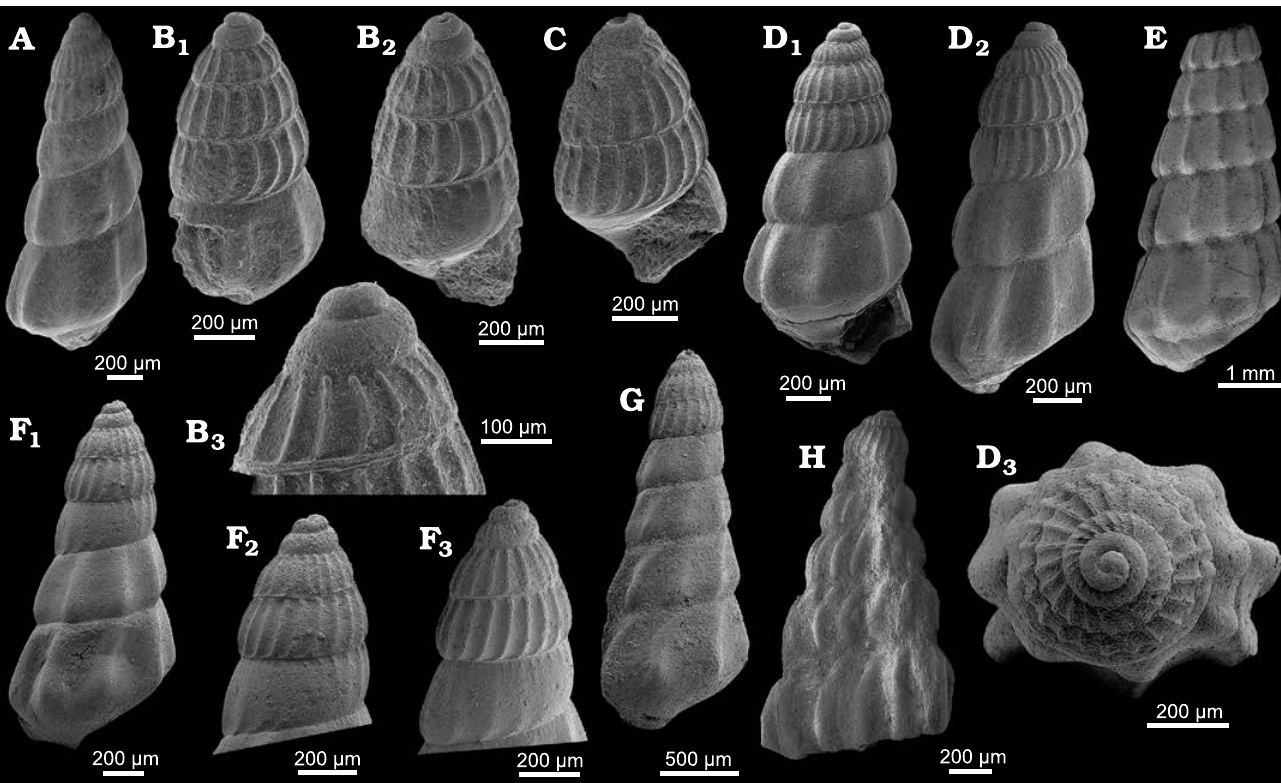
Fig. 17. Zygopleurid gastropods from Lago Antorno (A–C) and Misurina Landslide (D–H), northern Italy, Cassian Formation, Carnian, Upper Triassic. A . Ampezzopleura hybridopsis Nützel, 1998, PZO 12831, axially ribbed larval shell and 3 teleoconch whorls, in lateral view. B . Ampezzo pleura hybridopsis Nützel, 1998, PZO 12832, axially ribbed larval shell and 1 teleoconch whorl, in lateral view (B 1 ), B 2 , last whorl axial ribs reduced to subsutural nodes, in lateral view; B 3 , earliest whorls smooth, then strong axial ribs, in lateral view. C . Ampezzopleura hybridopsis Nützel, 1998, PZO 12833, axially ribbed larval shell. D . Ampezzo pleura hybridopsis Nützel, 1998, PZO 12705, axially ribbed larval shell and 2 teleoconch whorls, in apertural (D 1 ), lateral (D 2 ), and apical (D 3 ) views. E . Ampezzo pleura hybridopsis Nützel, 1998, PZO 12706, teleoconch. F . Ampezzopleura hybridopsis Nützel, 1998, PZO 12707, axially ribbed larval shell and 3 teleoconch whorls, in lateral view (F 1 ), F 2 , protoconch in lateral view, axial ribs of larval shell reduced to subsutural nodes on last whorl; F 3 , protoconch in lateral view, axial ribs of larval shell reduced to subsutural nodes and teleoconch ribs begin to appaer on last whorl. G . Ampezzo pleura hybridopsis Nützel, 1998, PZO 12708, axially ribbed larval shell and 4 teleoconch whorls, in lateral view. H . Ampezzopleura bandeli Nützel, 1998, PZO 12703, protoconch and ca. 4 teleoconch